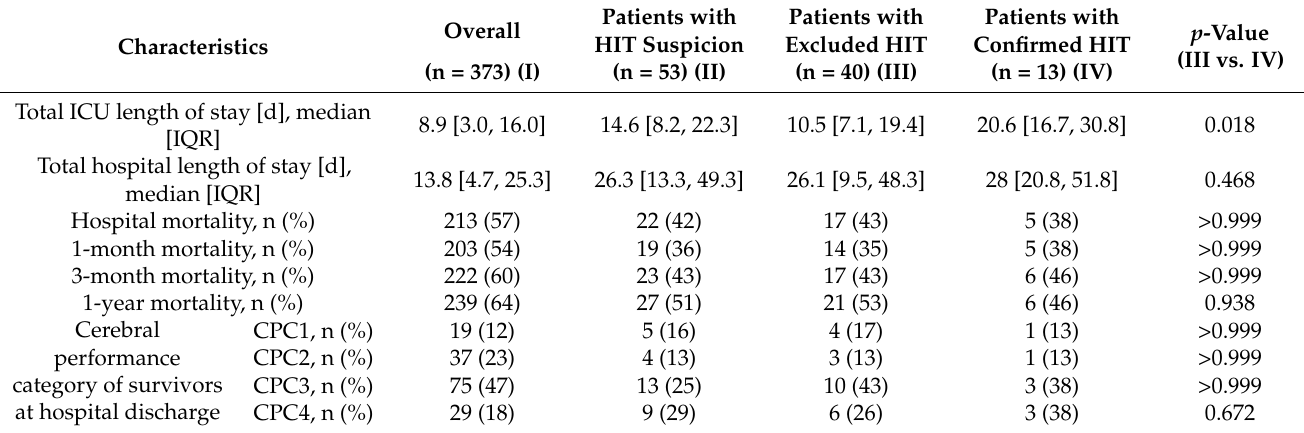
Table 4. Outcome of VA-ECMO treatment.